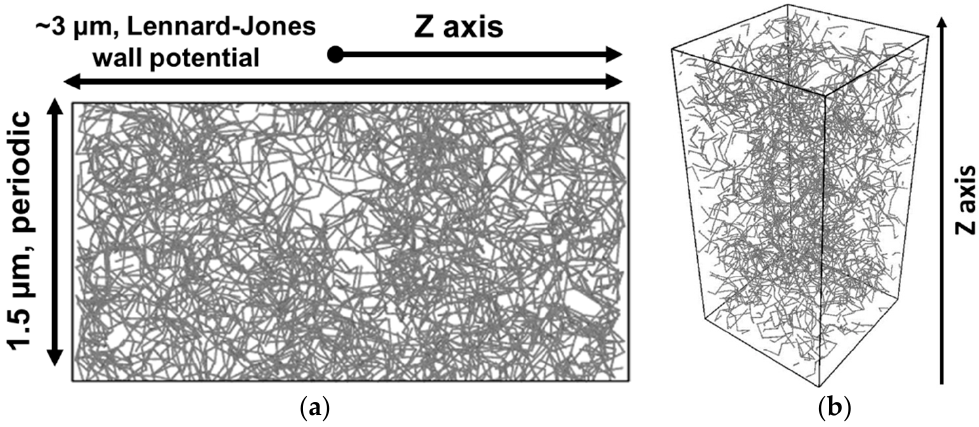
Figure 5. An example of a cell simulated by molecular dynamics (MD) methods with distributed carbon nanotubes (CNTs) with volume fraction of 0.5 vol%. ( a )—side view; ( b )—an oblique view. Numerical modeling was carried out for a set of CNTs content values (from 0.01 to 5 vol.%), temperatures, and values of the coefficients of the wall/CNT and CNT/CNT